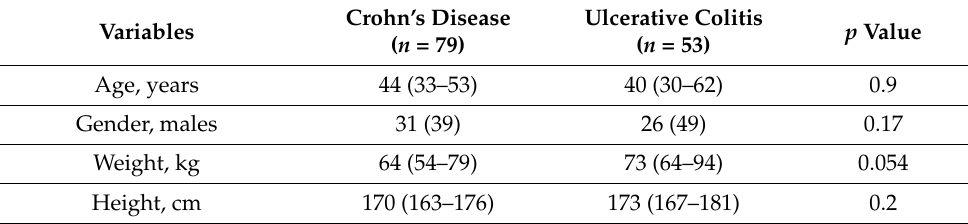
Table 4. Characteristics of patients according to type of diagnosis (Crohn‘s disease versus ulcera- tive